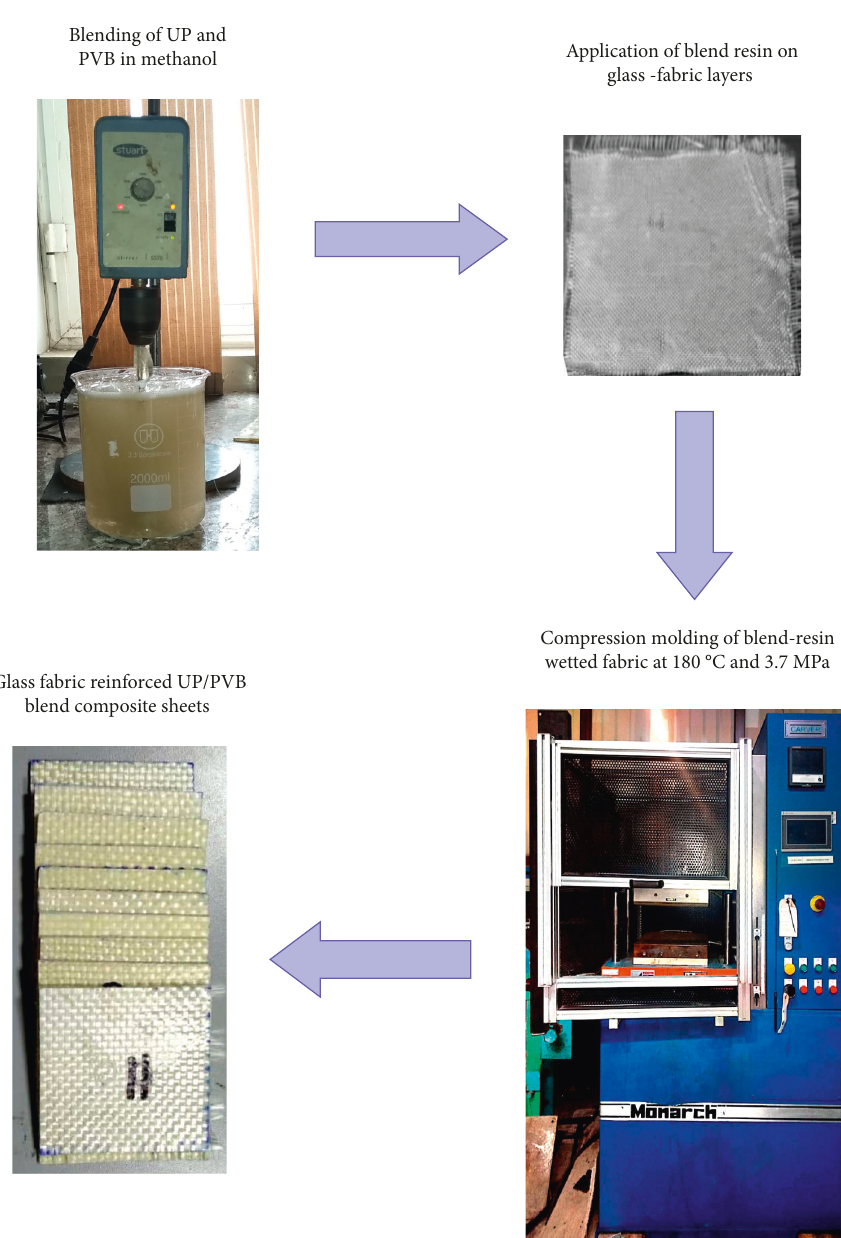
Figure 2: Experimental setup for the fabrication of PVB/UP blend composite sheets.